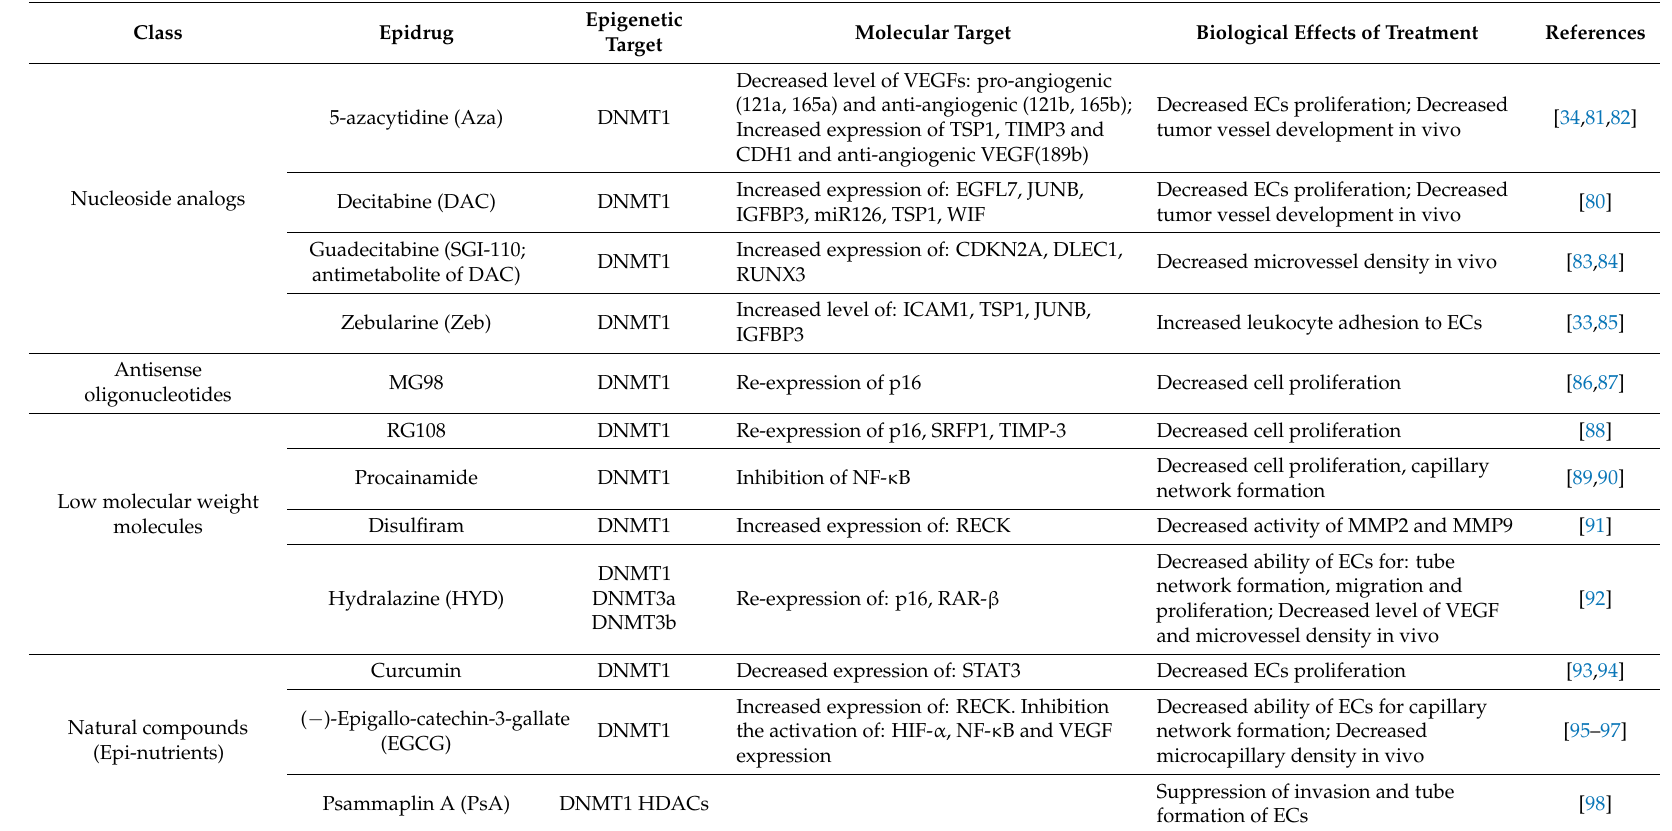
Table 3. Targeting tumor angiogenesis via DNA hypomethylating